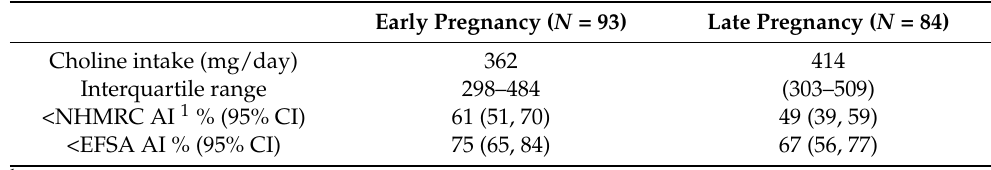
Table 2. Median choline intake and percentage of women consuming less than the National Health and Medical Research Council (NHMRC) and European Food Safety Authority (EFSA) adequate intake (AI) for choline in early and late pregnancy.